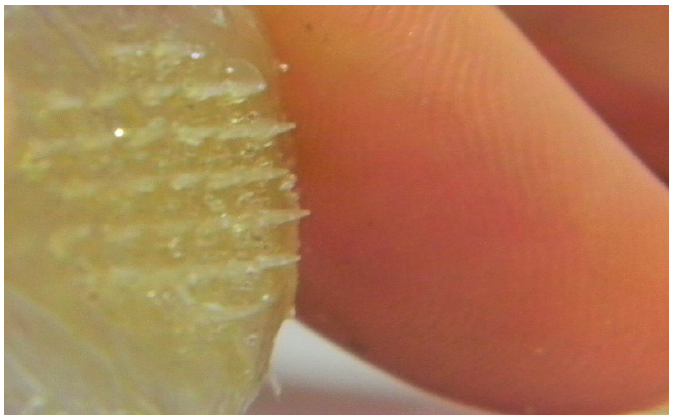
Figure 11. Microneedle array formed from FSBP-NC 20 g at 80 °C placed next to a human